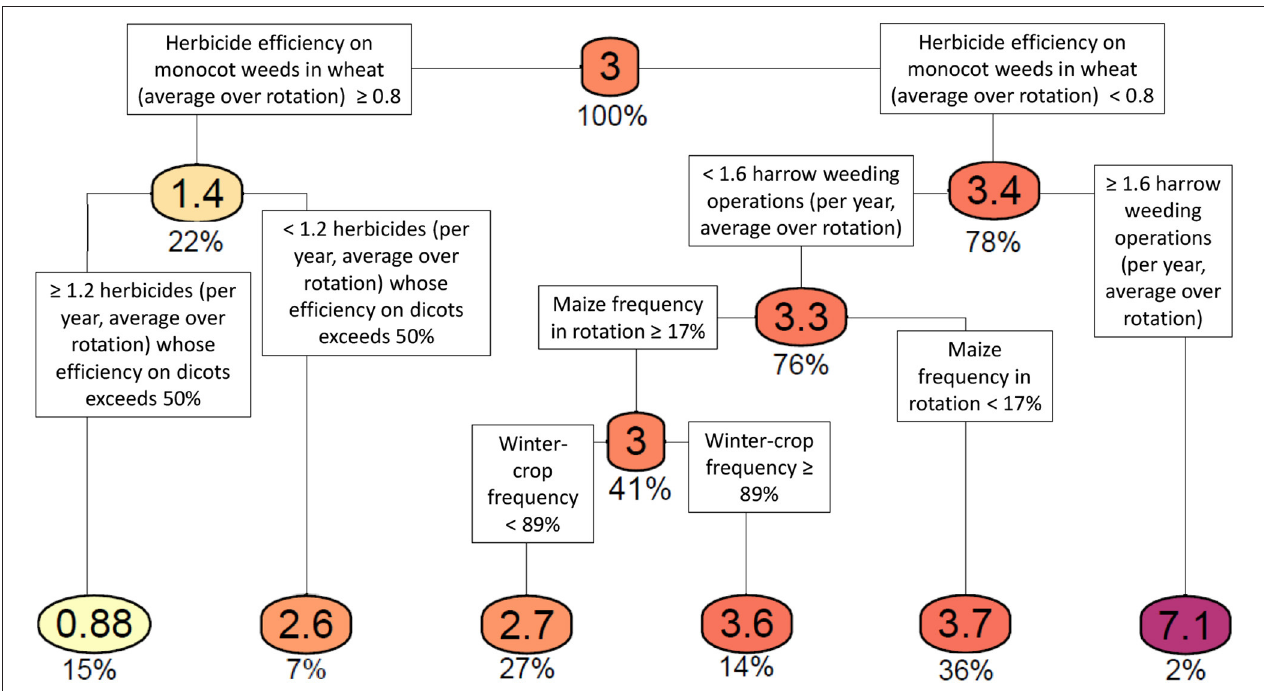
FIGURE 2 | Typology of cropping systems with different tillage frequencies (indicated in nodes and leaves, colored from (cid:4) = lowest to (cid:4) = highest value, with % data included in node shown below) in the data set consisting of 395 cropping systems. Classification and regression tree explaining the number of tillage operations per year on average over the rotation from cropping-system variables other than tillage-related variables. Percentages below nodes and leaves indicate the percentage of systems among the total 395 systems. Total R ² is 0.59, partial R ² are 0.38, 0.11, and 0.10 for impacts of herbicides, mechanical weeding, and rotation, respectively ( Colbach, 2022